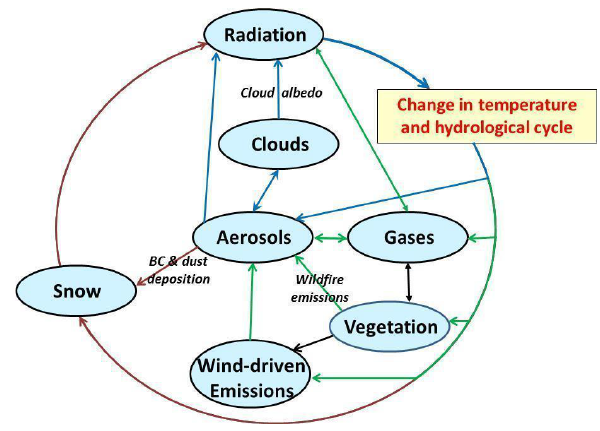
Fig. 3. Interactions between aerosols, gases and components of the Earth